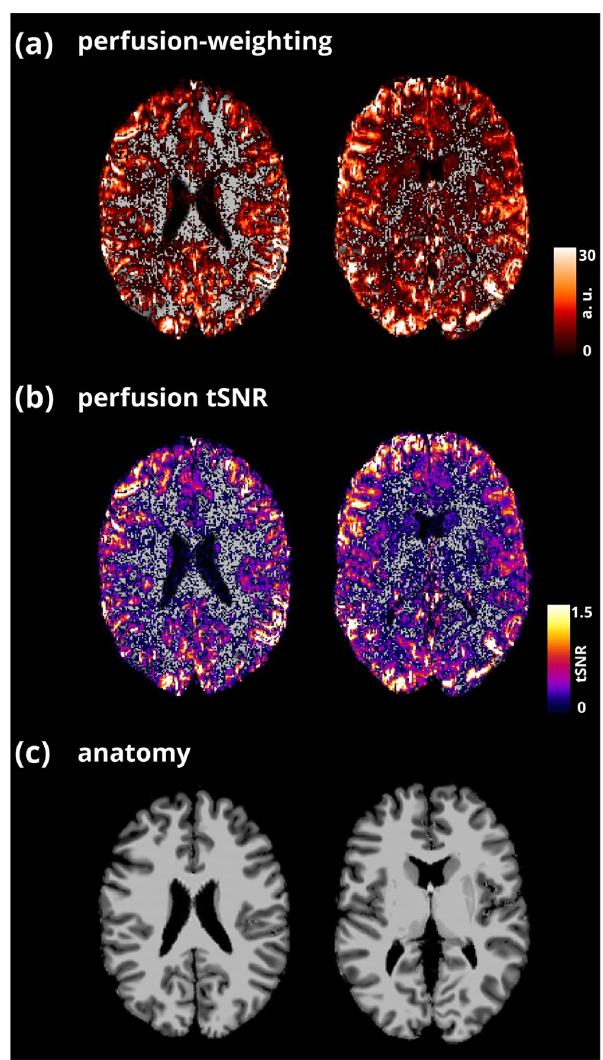
Fig 1. The average baseline perfusion (a) and perfusion tSNR (b) maps from a superior (left) and inferior (right) slice of an example participant is shown overlaid on the corresponding T 1 -weighted anatomical image